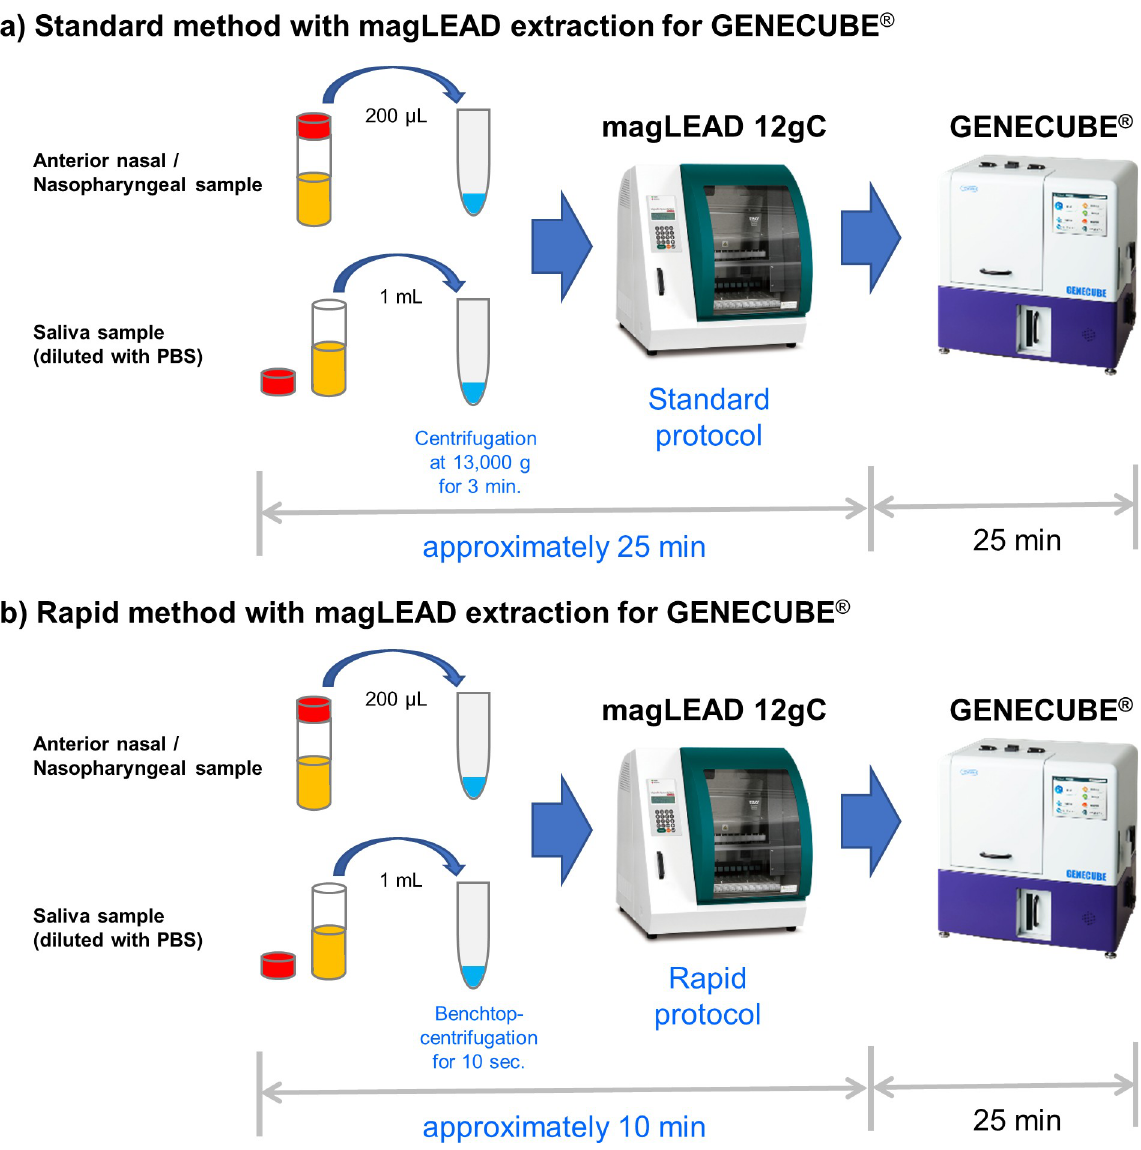
Fig 1. Workflow of the two extraction methods for the GENECUBE 1 assay in this study. The rapid method with magLEAD extraction (b) newly developed in this study takes as little as 10 min for viral RNA extraction, while the standard method (a) takes approximately 25 min. For the rapid protocol, in the preparation of saliva samples, purification and extraction processes were adjusted, and the total process time was shortened. PBS Phosphate-buffered saline. For magLEAD 12gC, the picture was reprinted from [13] under a CC BY license with the permission of Precision System Science Co., Ltd., 2016. For GENECUBE, the picture was reprinted from [14] under a CC BY license with the permission of TOYOBO Co., Ltd.,